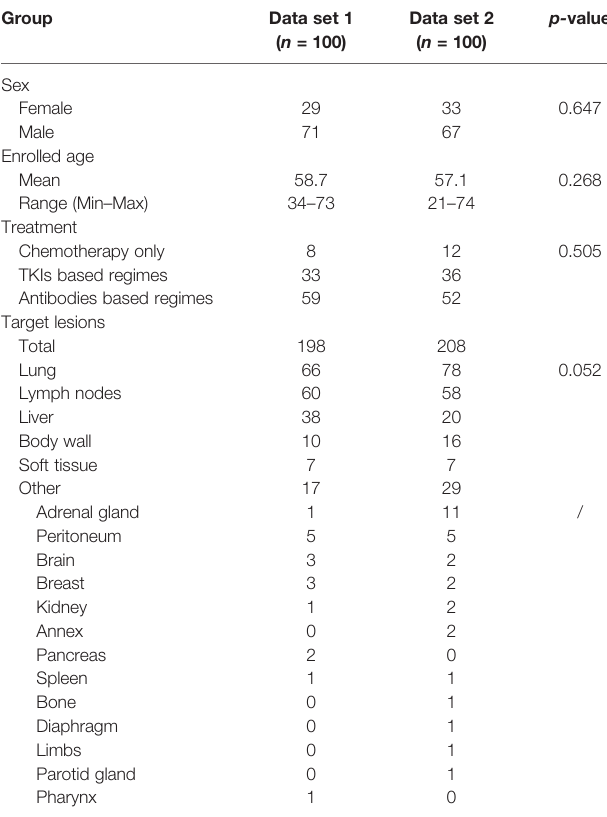
TABLE 1 | The demographic and clinical characteristics of the experiential learning data set (data set 1) and testing data set (data set 2). Group